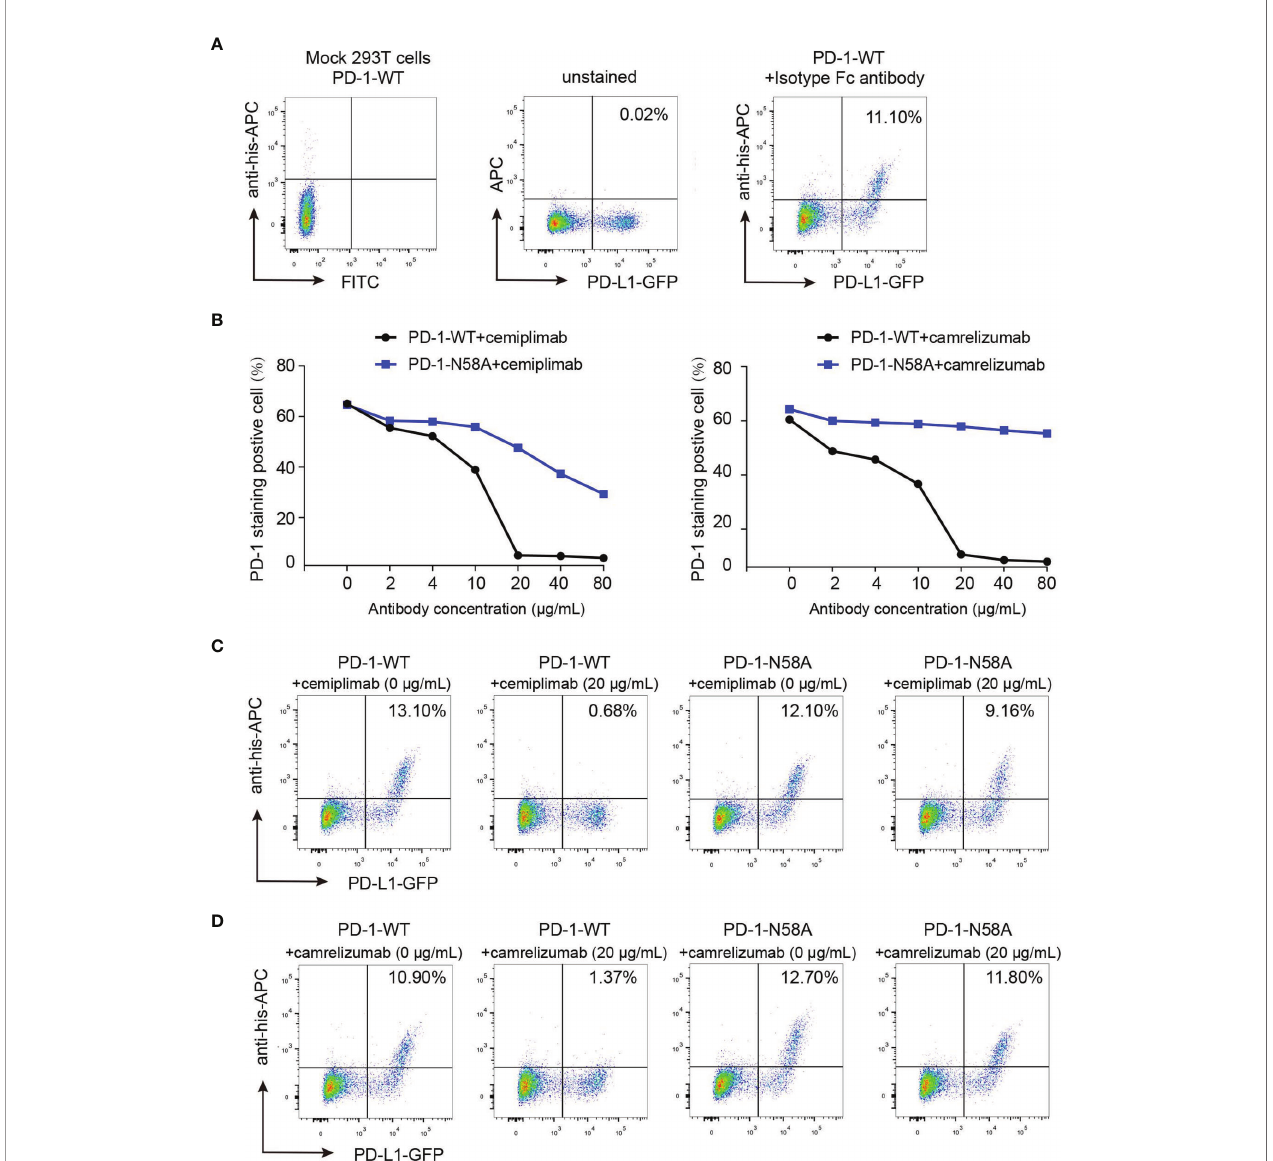
FIGURE 6 | Reduced blocking ef fi ciency of cemiplimab to N58 glycosylation-de fi cient PD-1. (A) Untransfected 293T cells and transfected 293T cells incubated with isotype antibody as negative control. (B) The blocking of the binding of His-tagged PD-1-WT (blank) or PD-1-N58A (blue) proteins to PD-L1 expressing 293T cells is analyzed with varying concentrations (0, 2, 4, 10, 20, 40, and 80 m g/ml) of full-length cemiplimab (left) or camrelizumab (right). The PD-L1 expressing 293T cells staining with His-tagged PD-1-WT or PD-1-N58A are prepared as a positive control. (C, D) The frequencies of the His-tagged PD-1-WT or PD-1-N58A protein staining positive subpopulations in the absence (0 m g/ml) or presence (20 m g/ml) of cemiplimab (C) or camrelizumab (D) . At the same concentration (20 m g/ml) of cemiplimab or camrelizumab, the frequency of His-tagged PD-1-WT or PD-1-N58A staining positive cells was calculated based on PD-L1-GFP-positive cells. The experiment was repeated twice in the results